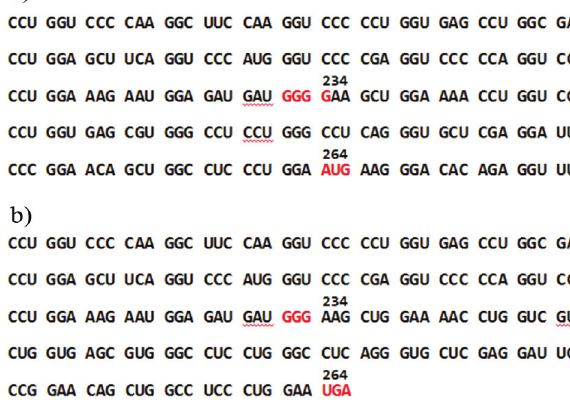
Figure 3 - Comparison of mRNA sequences from the wild-type control and proband. The mRNA sequence is shown from nucleotide 586 (codon 196) in exon 9 to nucleotide 810 (codon 270) in exon 10 with nucleotide 1 defined as the A of the AUG/ATG translational start codon. The splicing of introns between exon 9 and 10 removed the first G of a five-G sequence in the parental cDNA, providing four Gs from nucleotide c.697-700, whereas the proband mutant COL1A1 mRNA only contained a 3-G se- quence. This c.700delG genotype induced a frameshift mutation in the proband and her mother. (A) Wild-type COL1A1 mRNA. (B) Proband COL1A1 mRNA with the 700delG